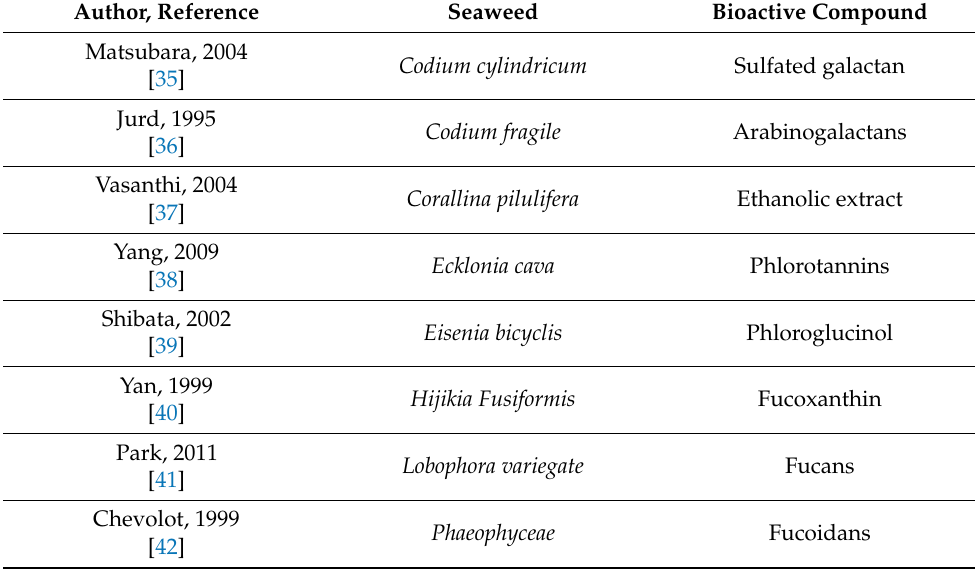
Table 1. Bioactive compounds from